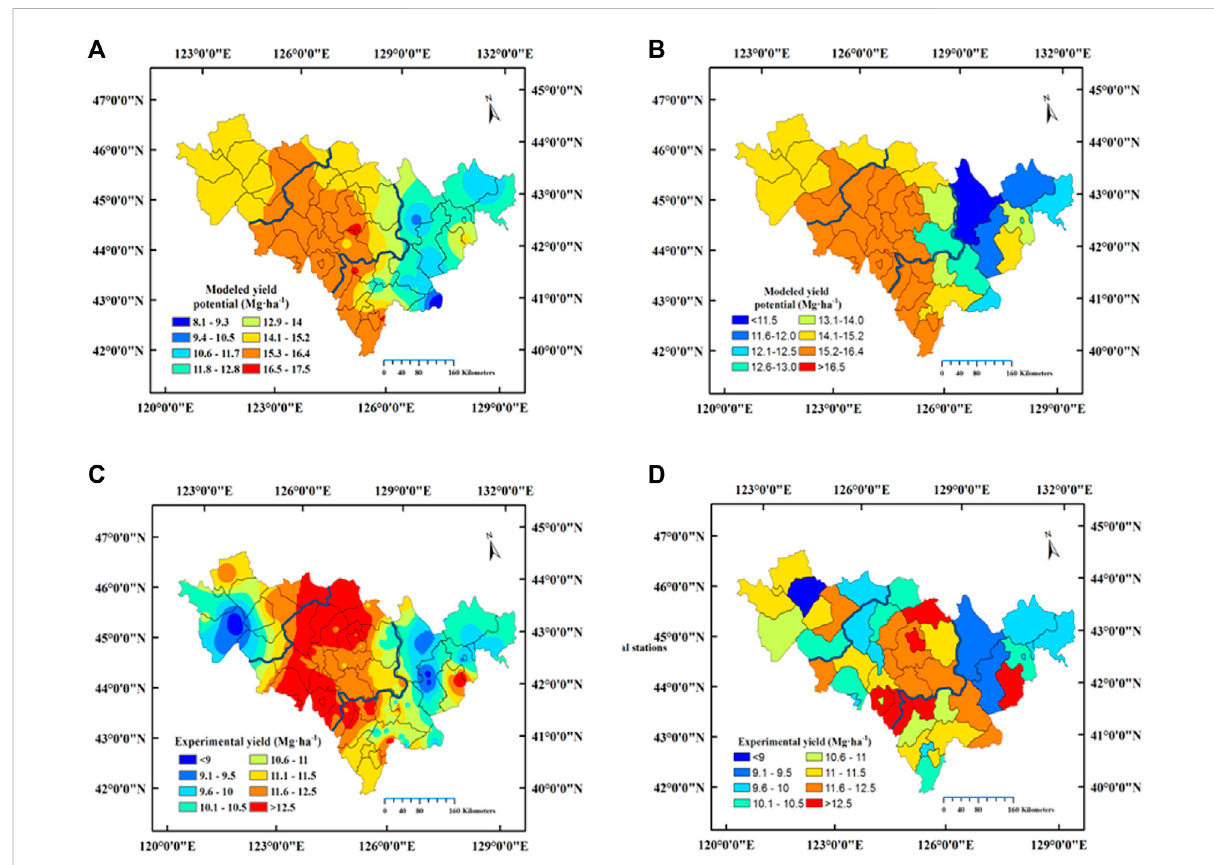
FIGURE 3 Spatial distribution of the modeled yield potential and attainable yield potential for Jilin province. (A) Modeled yield potential using the ordinary Kriging method in ArcGIS based on the simulated results of all 27 weather stations; (B) modeled yield potential at the county level using the tool command of “ zonal statistics as table ” according to the maize sowing area for 2006 – 2008. (C) Attainable yield potential was estimated by interpolationandamapusingArcGISbasedonthesimulatedresultsofall87sites; (D) attainableyieldpotentialatthecountylevelusingthetool commandof “ zonalstatistics astable ” accordingtothemaizesowingarea for2006 – 2008.Black linesaretheboundariesofcounties,and dark-blue lines are the boundaries of the eastern humid mountainous area (EHMA), central semi-humid plain area (CSPA), and western semi-arid plain area